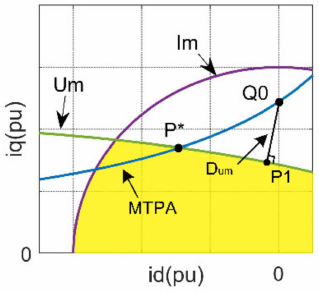
Figure 7. The optimization problem of CFW-MPC. Um: voltage limitation; Im: current limitation; Te: electrical torque trajectory.